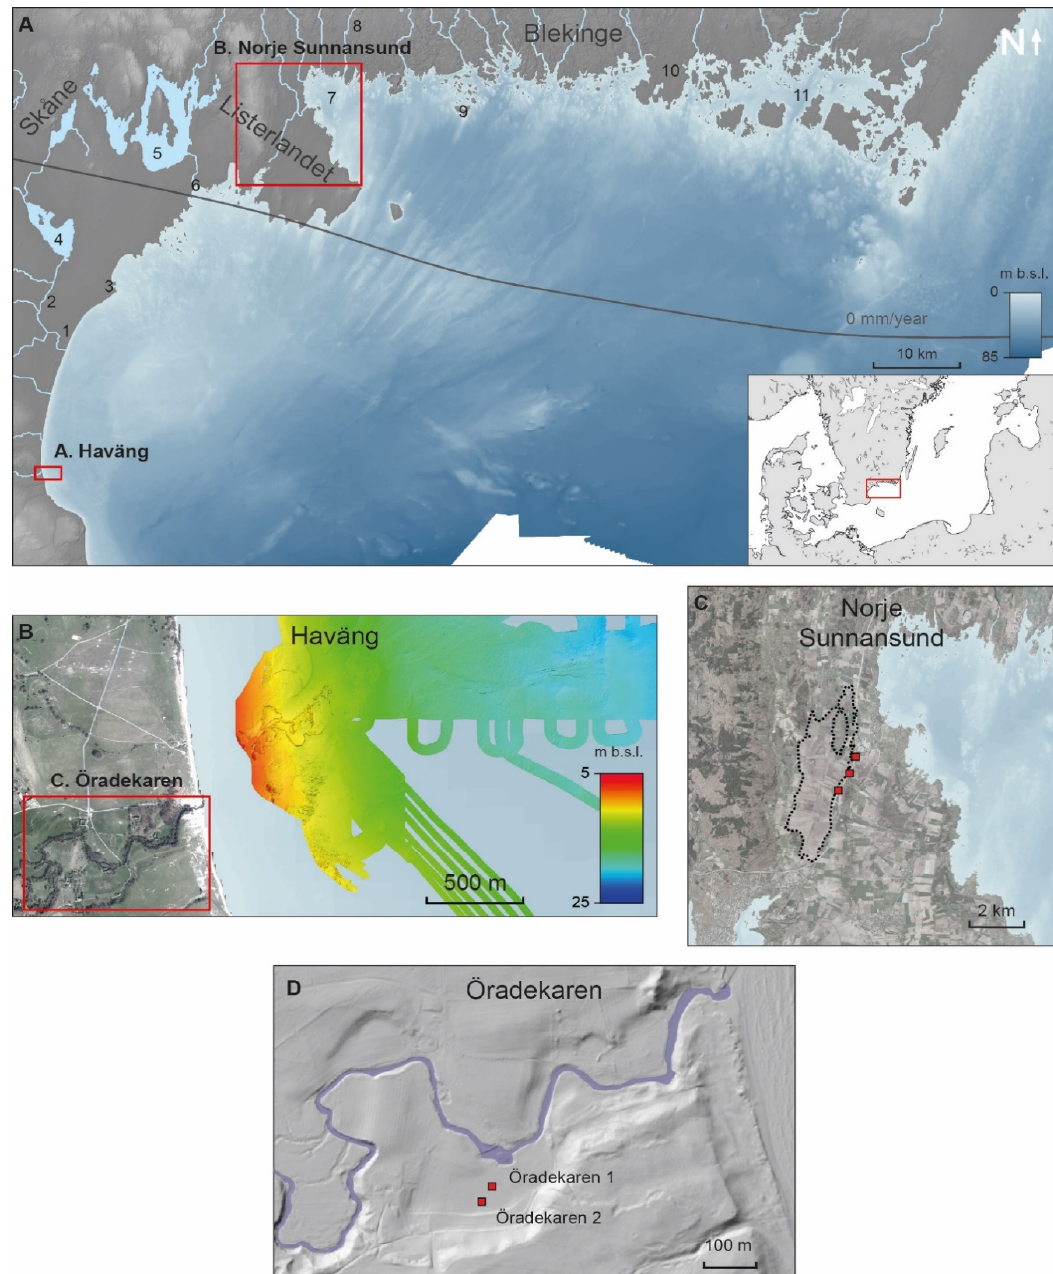
Figure 1. ( A ) Topographic and bathymetric map of the Hanö Bay region in south-eastern Sweden, with study areas indicated. The Grey line represents the 0 mm/year apparent land uplift [59]. Sites mentioned in the text (1) Yngsjö, (2) Helge Å River, (3) Åhus, (4) Lake Hammarsjön, (5) Lake Ivösjön, (6) Skräbeån River Mouth (7) Pukavik Bay (8), Mörrumsån River, (9) Tärnö Island, (10) Gö Peninsula and (11) Karlskronafjärden. ( B ) The Haväng study site is represented by the bathymetric map east of the present coastline and the aerial photograph of the coastline and the Verkeån River mouth. ( C ) The Norje Sunnansund study site on the Listerlandet Peninsula, consisting of the Lussabacken norr, the Damm 6 and Bro 597 and the Norje Sunnansund sites, respectively, shown by red squares from south to north. The extent of Ancient Lake Vesan is marked by dashed lines. ( D ) The Öradekaren site located adjacent to the Verkeån River in the Haväng area. The location of the sediment sequences obtained are marked by red squares. Satellite imagery source: ESRI, DigitalGlobe, GeoEye, Earthstar Geographics, CNES/Airbus DS, USDA, USGS, AeroGRID, IGN and the GIS User Community. LIDAR data © Lantmäteriet.